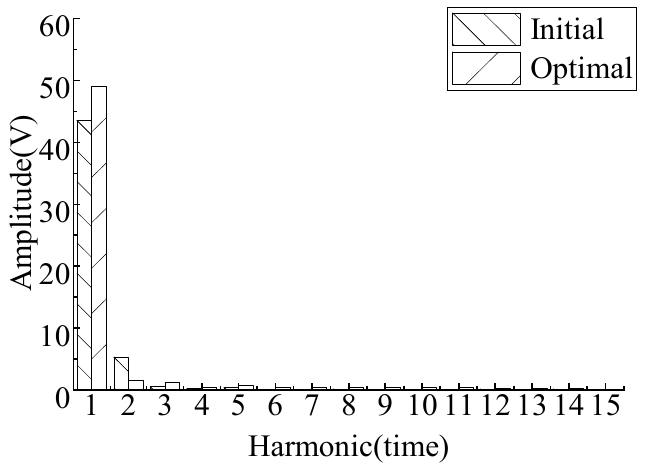
Figure 7. Comparison of harmonic.